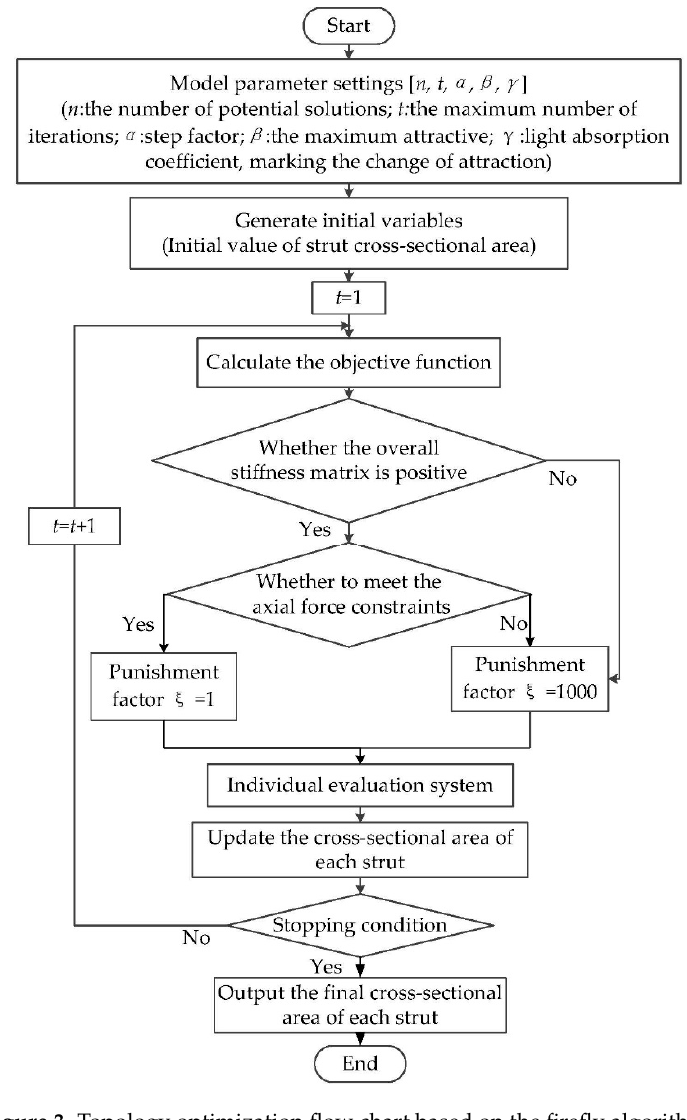
Figure 3. Topology optimization flow chart based on the firefly algorithm.